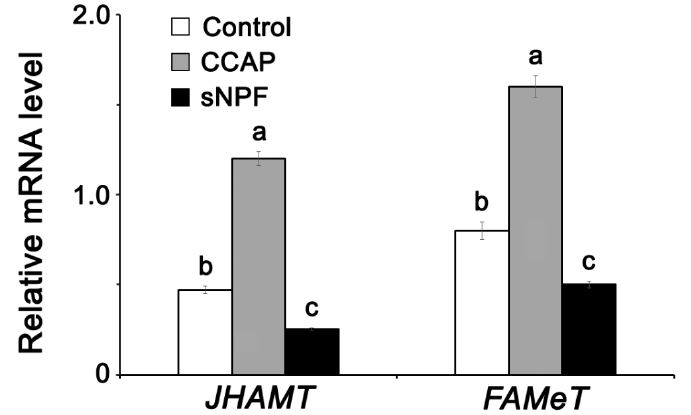
Figure 6. JHAMT and FAMeT expression in the fat body 4 days after CCAP and sNPF injection into normally fed P. americana . Data are presented as mean ± SEM. Means followed by unlike letters are significantly di ff erent ( p < 0.05), using Duncan’s test.